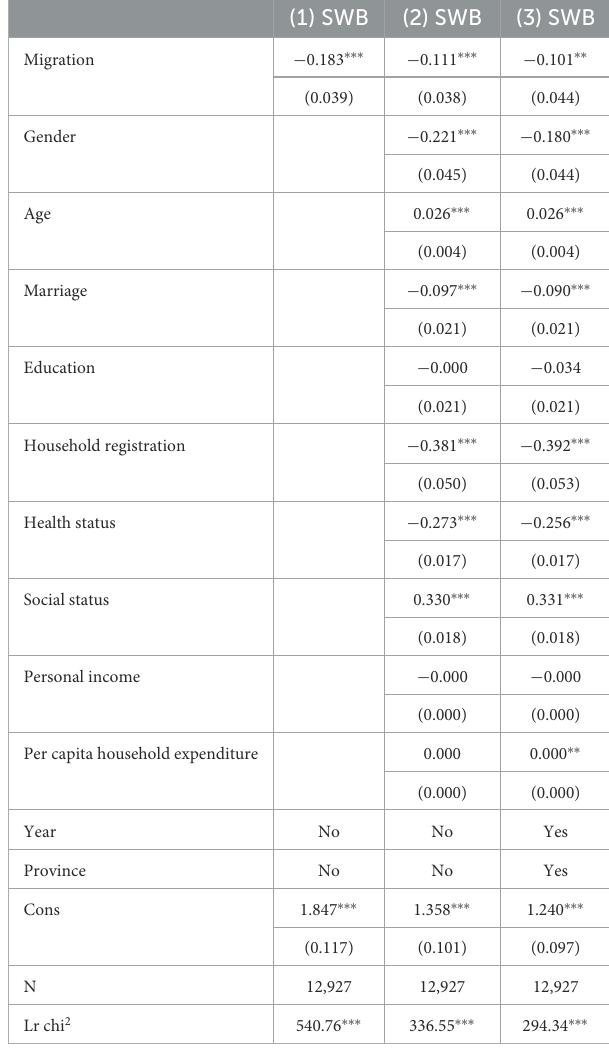
TABLE 2 Baseline regression